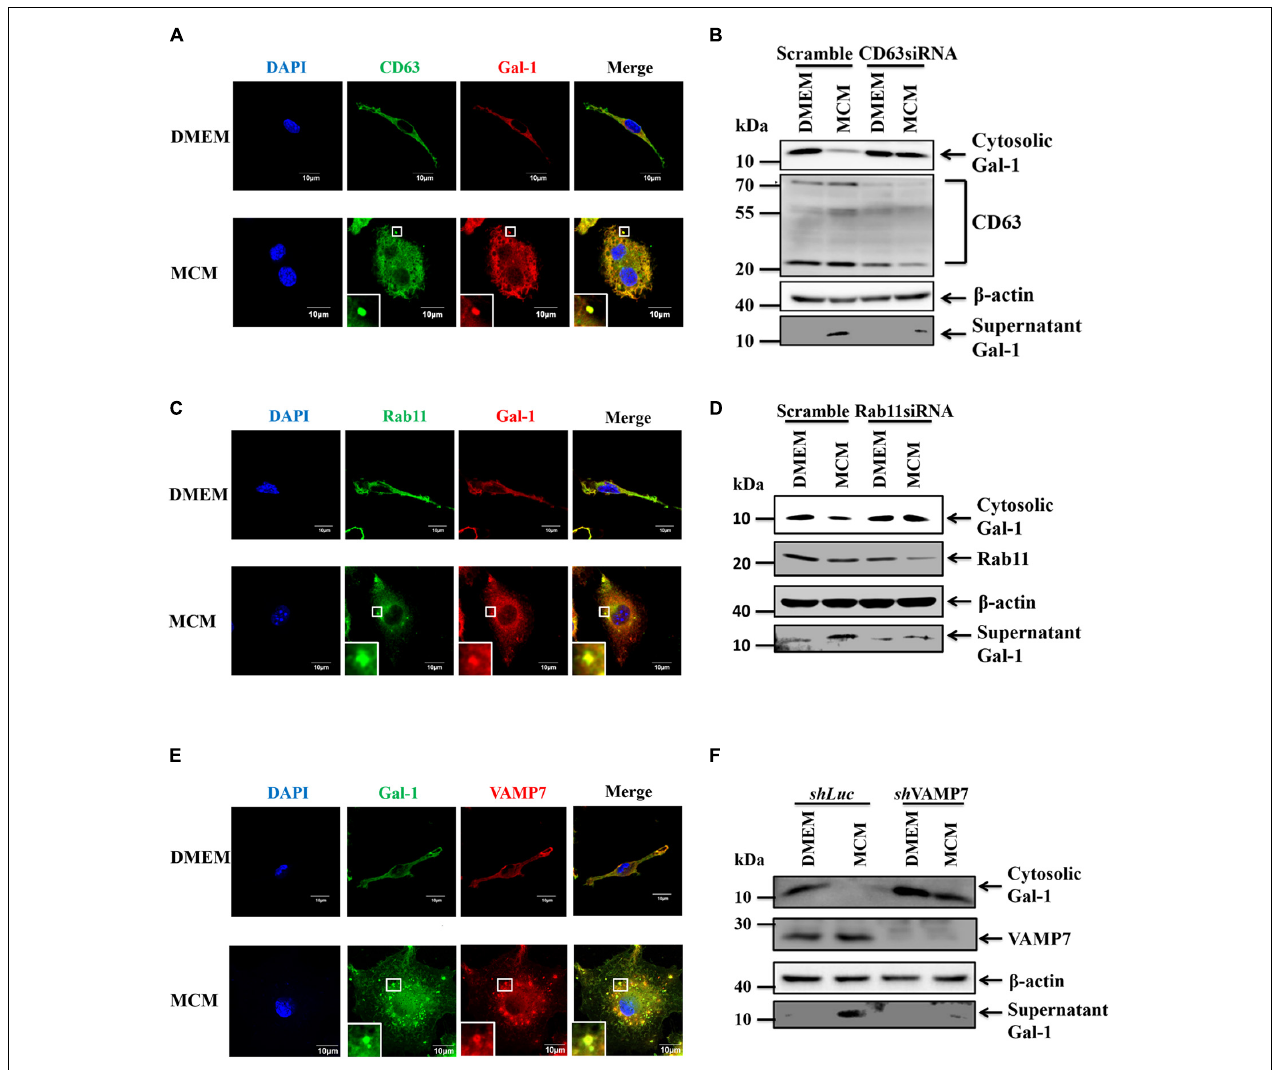
FIGURE 3 | MVB, Rab11, VAMP7 triggered amphisome formation mediates Gal-1 secretion. (A) BMDMs were treated with MCM for 12 h and then stained with anti-CD63 (green) and anti-Gal-1 (red) antibodies. The co-localization of CD63 and Gal-1 was observed by confocal microscopy. Scale bar = 10 µ m. (B) RAW 264.7 cells were transfected with control or CD63 siRNA for 24 h and then treated with MCM for another 24 h. The expression of cytosolic Gal-1, CD63, β -actin, and supernatant Gal-1 proteins was determined by Western blotting. All blots were derived from a single experiment. (C) BMDMs were treated with MCM for 12 h and then stained with anti-Rab11 (green) and anti-Gal-1 (red) antibodies. The co-localization of Rab11 and Gal-1 was observed by confocal microscopy. Scale bar = 10 µ m. (D) RAW 264.7 cells were transfected with control or Rab11 siRNA for 24 h and then treated with MCM for another 24 h. The expression of cytosolic Gal-1, Rab11, β -actin, and supernatant Gal-1 proteins was determined by Western blotting. All blots were derived from a single experiment. (E) BMDMs were treated with MCM for 12 h and then stained with anti-Gal-1 (green) and anti-VAMP7 (red) antibodies. The co-localization of VAMP7 and Gal-1 was observed by confocal microscopy. Scale bar = 10 µ m. (F) shLuc and shVAMP7 RAW264.7 cells were treated with MCM for 24 h. The expression of cytosolic Gal-1, VAMP7, β -actin, and supernatant Gal-1 proteins was determined by Western blotting. All blots were derived from a single